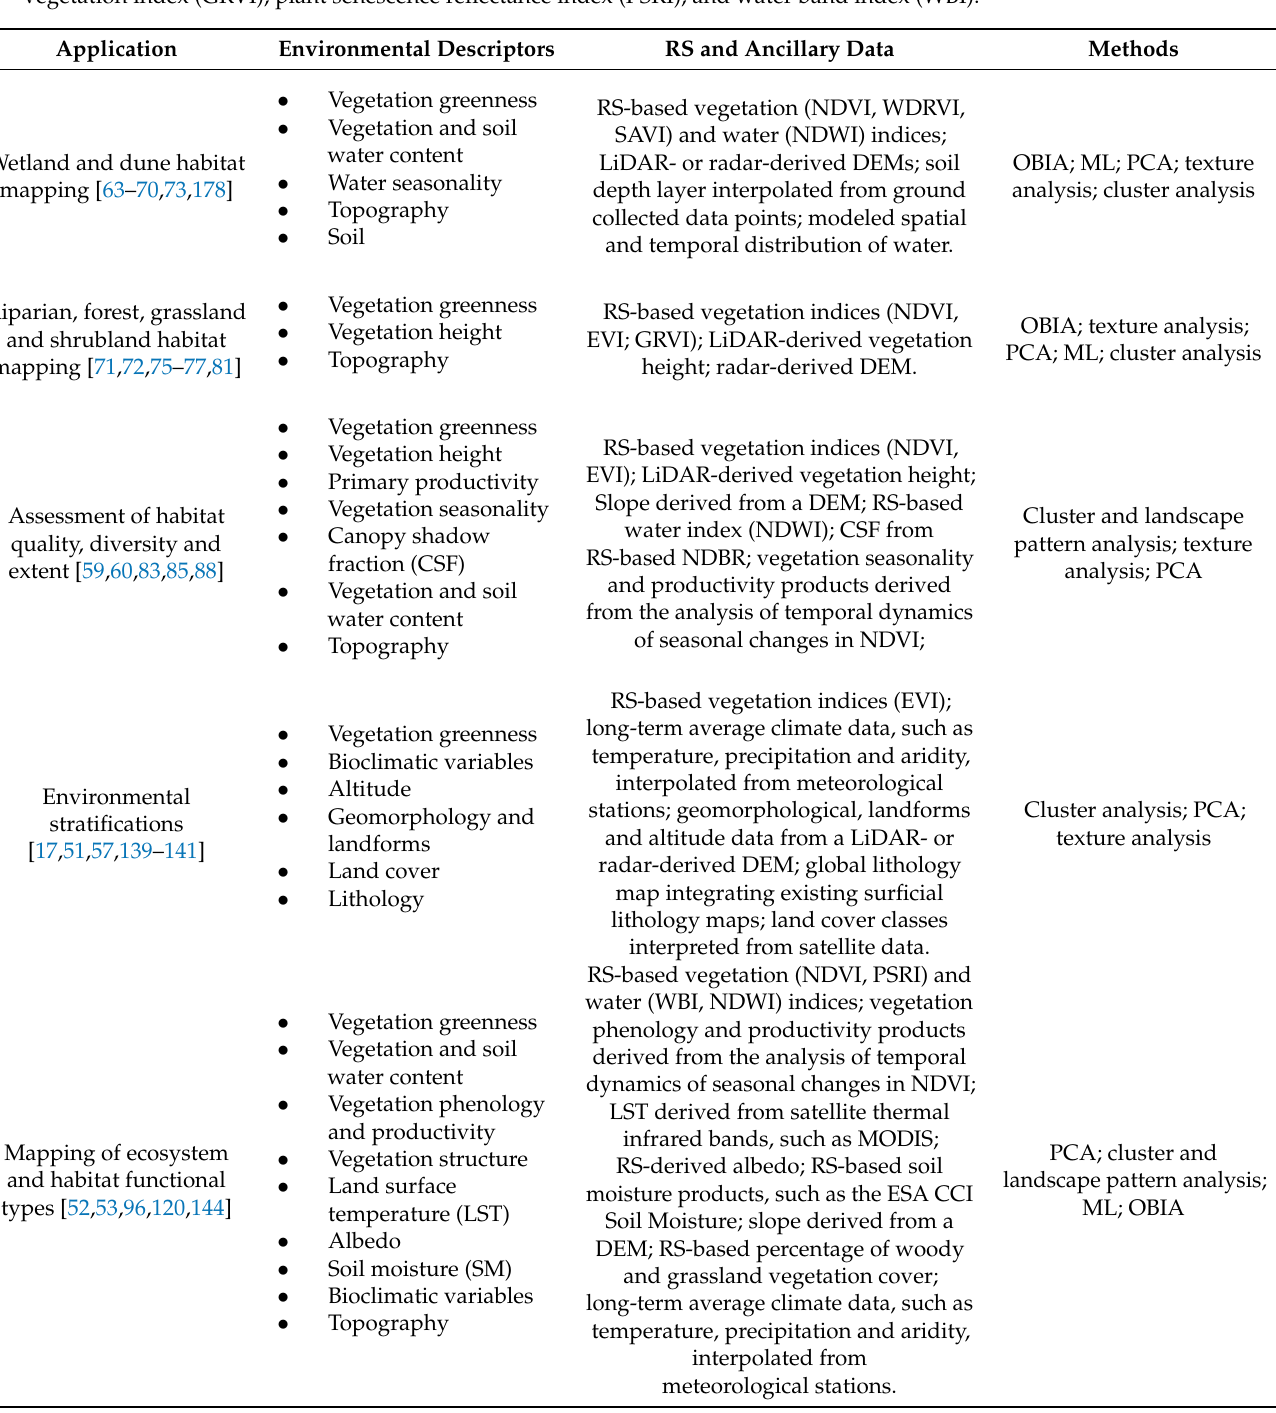
Table 2. Summary table with example applications of different environmental descriptors, including data and methods, that are relevant for the biophysical characterization of PAs. Acronyms used: object-based image analysis (OBIA); normal- ized difference vegetation index (NDVI); normalized difference water index (NDWI); machine learning (ML); principal components analysis (PCA); light detection and ranging (LiDAR); digital elevation model (DEM); normalized difference blue/red ratio (NDBR); wide dynamic range vegetation index (WDRVI); soil-adjusted vegetation index (SAVI); green–red vegetation index (GRVI); plant senescence reflectance index (PSRI); and water band index